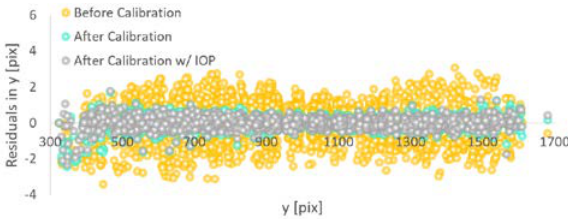
Figure 6: y-image residuals as a function of their row number in the image